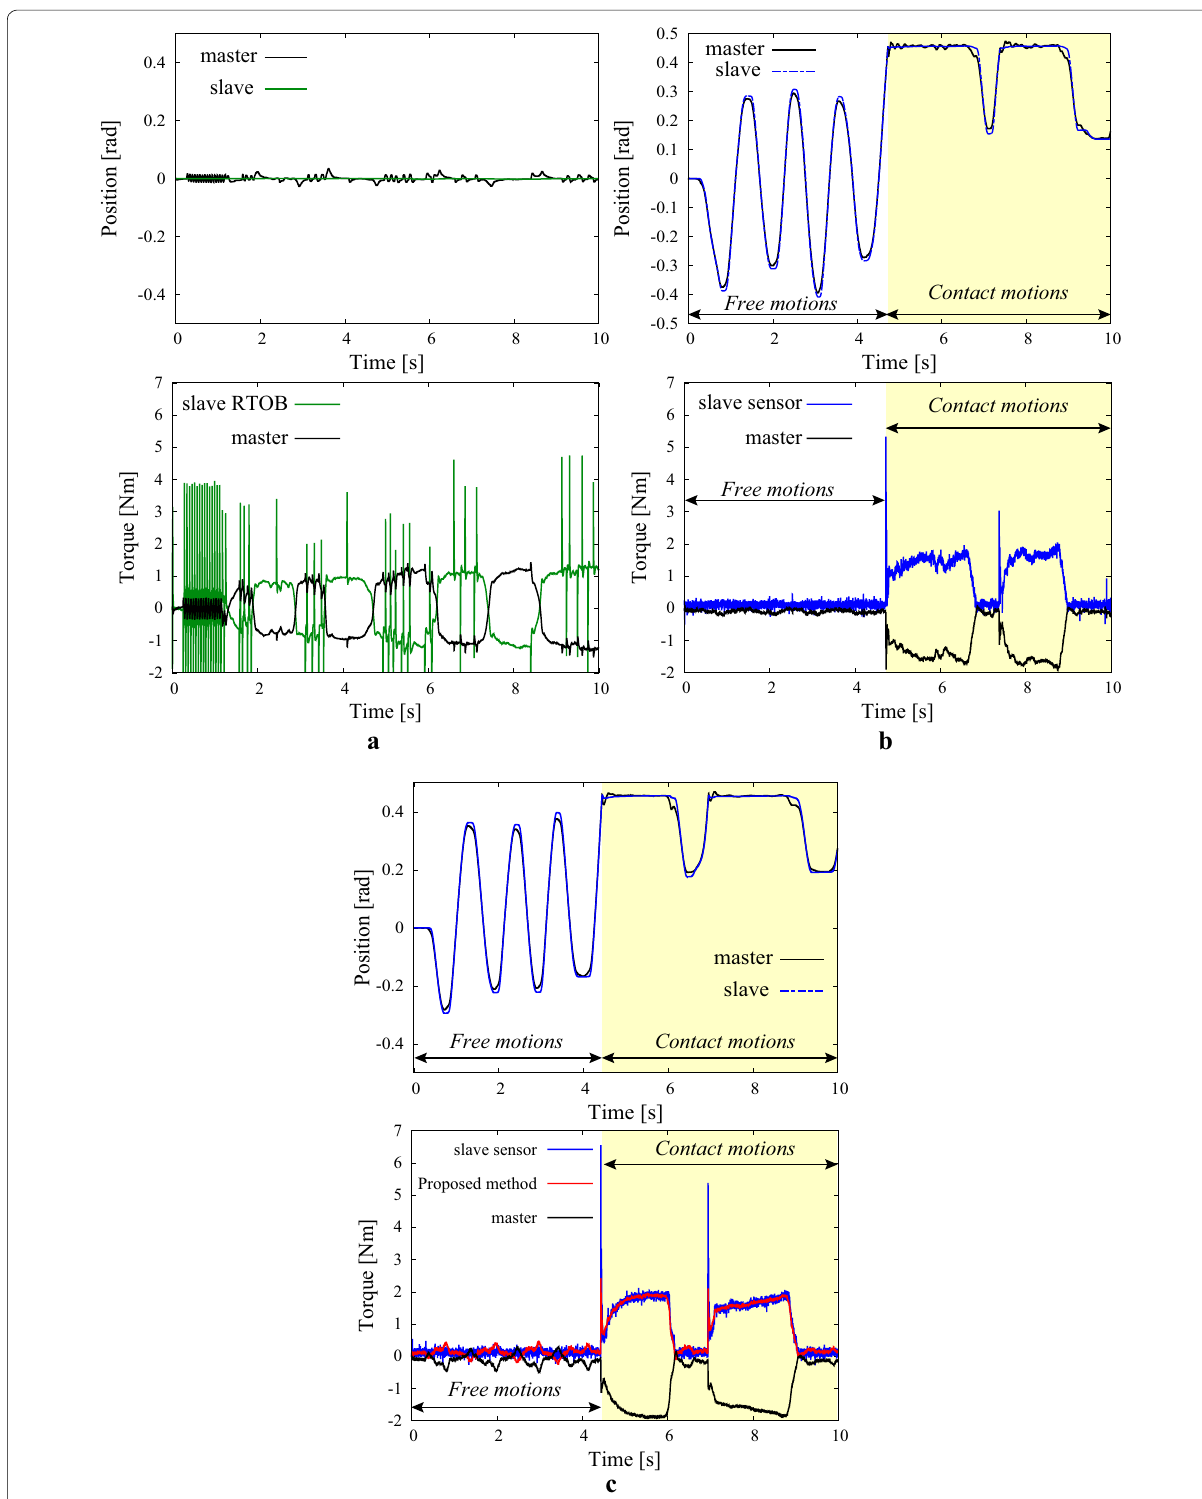
Fig. 17 Position and force responses of the bilateral control systems. a Bilateral control based on RTOB. b Bilateral control based on force sensor. c Bilateral control based on the proposed